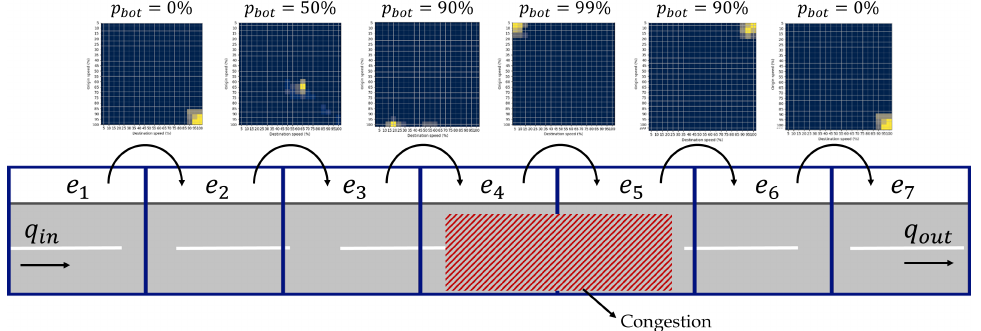
Figure 3. Overview of the proposed method for the bottleneck probability